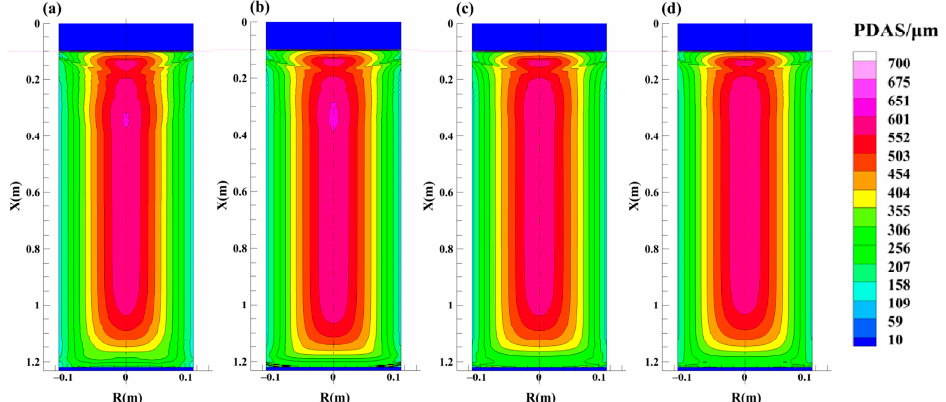
Figure A3. LST distribution with varying filling ratio: ( a ) 0.16, ( b ) 0.23, ( c ) 0.33 and ( d ) 0.43.